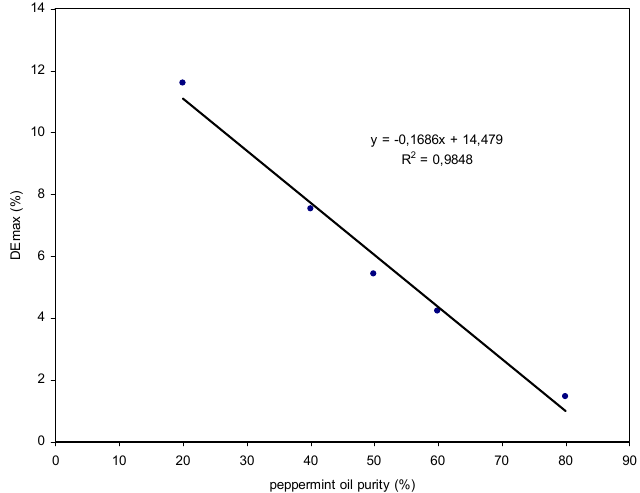
Figure 6. Maximum diffraction efficiency obtained as a function of the purity of the peppermint oil.